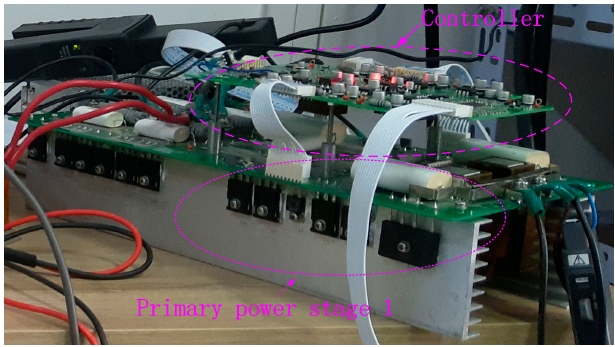
Figure 12. Photo of the prototype.